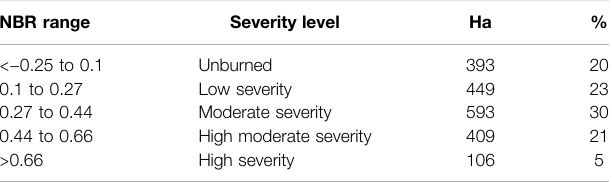
TABLE 3 | Fire severity by 10/09/2020 according to the classi fi cation by Key and Benson (2006). NBR range < −